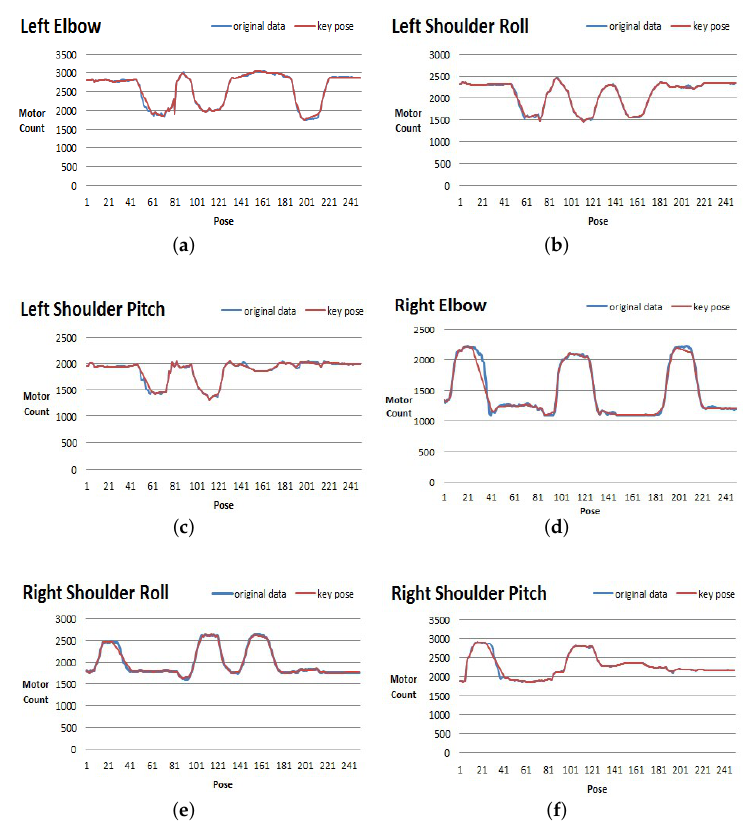
Figure 9. Results of [17] condition key-pose detection algorithm versus original pose data: ( a ) motor counts data on Left Elbow. ( b ) Motor counts data on Left Shoulder Roll. ( c ) Motor counts data on Left Shoulder Pitch. ( d ) Motor counts data on Right Elbow. ( e ) Motor counts data on Right Shoulder Roll. ( f ) Motor counts data on Right Shoulder Pitch.